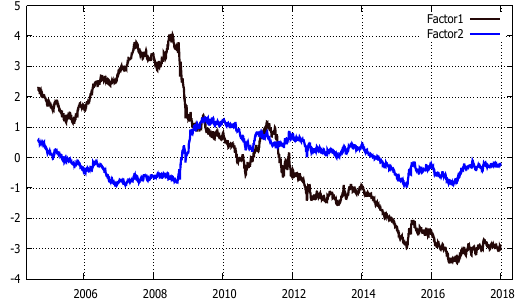
Figure A2. The Shadow Rate. Factor 1 explains 0.93 of variance, while Factor 2 explains